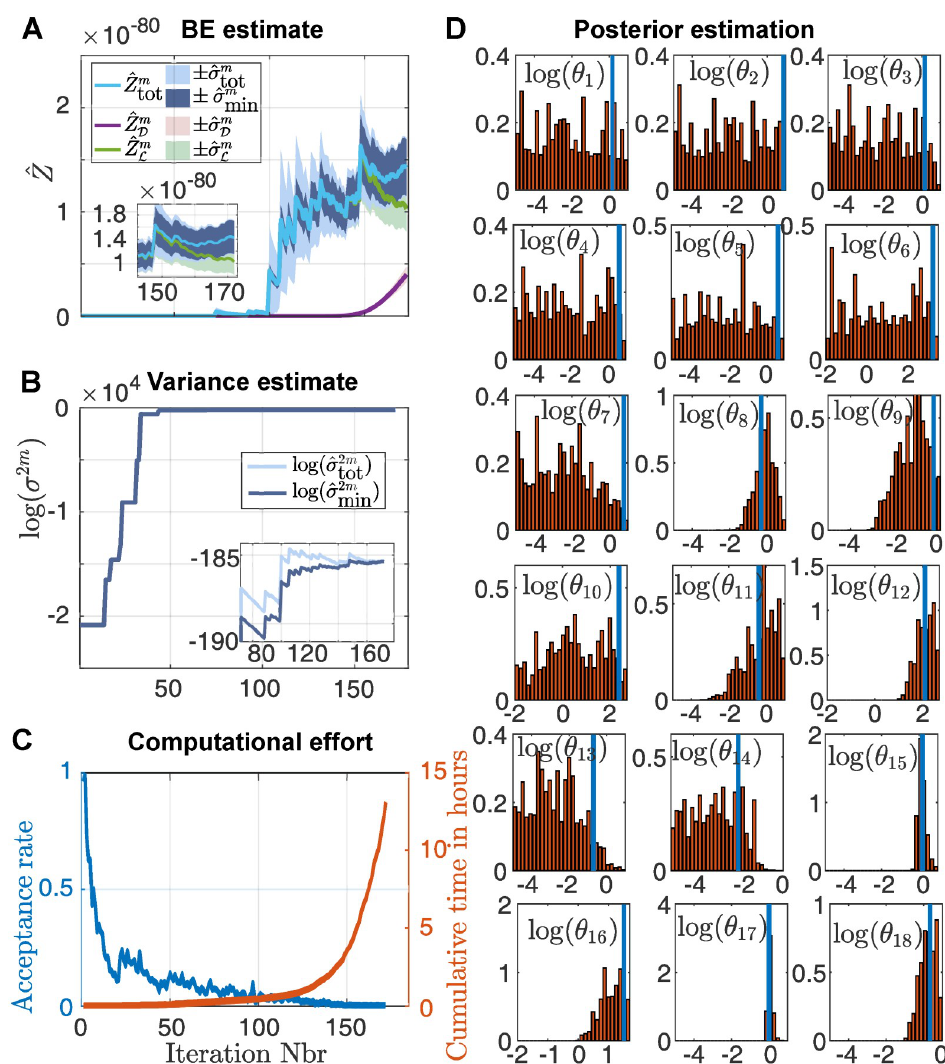
Fig 4. Inference on the Lac-Gfp model. A : Development of the estimation of the Bayesian evidence using the estimation based solely on the dead points ^ Z , the estimate approximation from the live points ^ Z and the estimation D L . The corresponding standard errors are indicated as the shaded areas. B : Estimate of the current that uses both ^ Z tot and the lower bounds for the lowest achievable variance ^ s 2 . C : The acceptance rate of the variance estimate ^ s 2 m tot min LF-NS algorithm for each iteration (blue) and the cumulative time needed for each iteration in hours (red). The computation was performed on 48 cores in parallel on the Euler cluster of the ETH Zurich. D : Marginals of the inferred posterior distributions of the parameters based on one simulated trajectory. The blue lines indicate the parameters used for the simulation of the